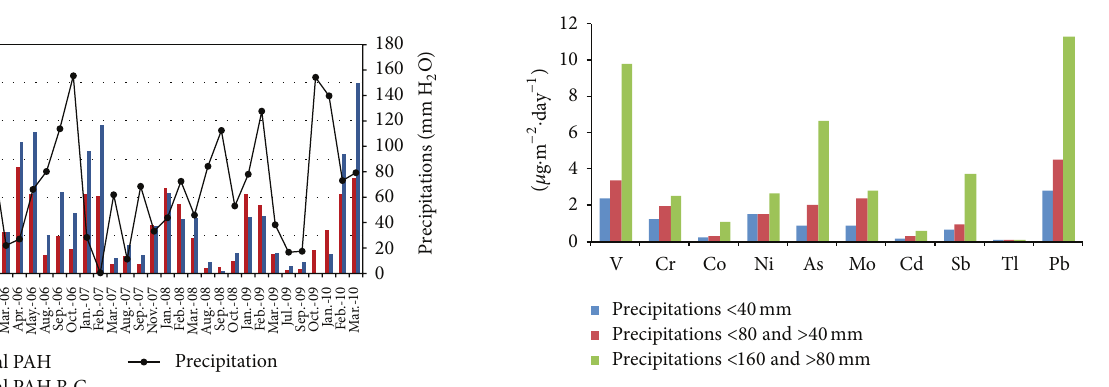
Figure 7: Fluxes of cadmium and antimony and precipitations in D4 from August 2005 to March 2010.